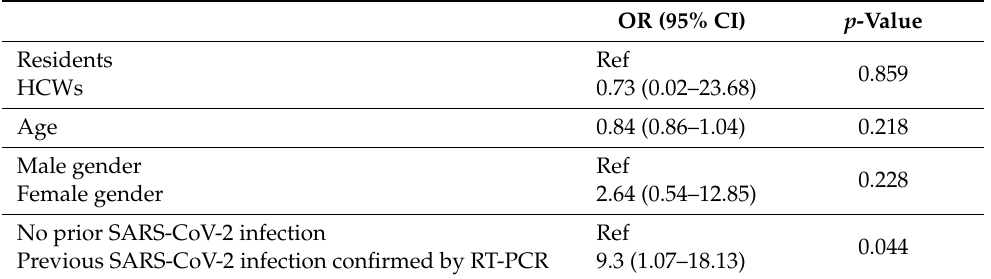
Figure 3. Serodynamics of anti-SARS-CoV-2 IgG according to participant group (t0: N = 534, t1: N = 404, t2: N = 314). ( a ) HCWs vs. residents; ( b ) males vs. females; ( c ) previous SARS-CoV-2 infection vs. no prior infection. Table 3. Predictors of developing a significant antibody response two weeks after a full vaccination cycle with Pfizer/BNT162b2 SARS-CoV-2 mRNA vaccine among healthcare workers (HCWs) and residents of 13 long-term care facilities of Piedmont, Italy,